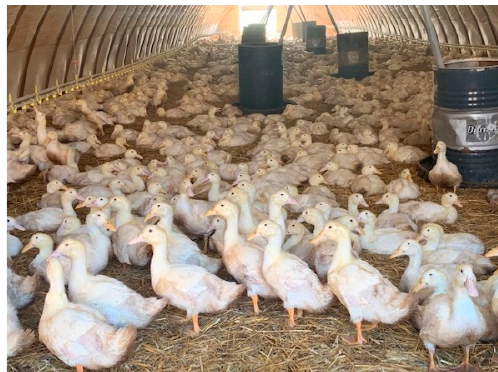
Figure 1. Cherry Valley ducks at the experimental site. The stock density was 23 ducks/m 2 during the two weeks of pre-rearing and 5.7 ducks/m 2 during